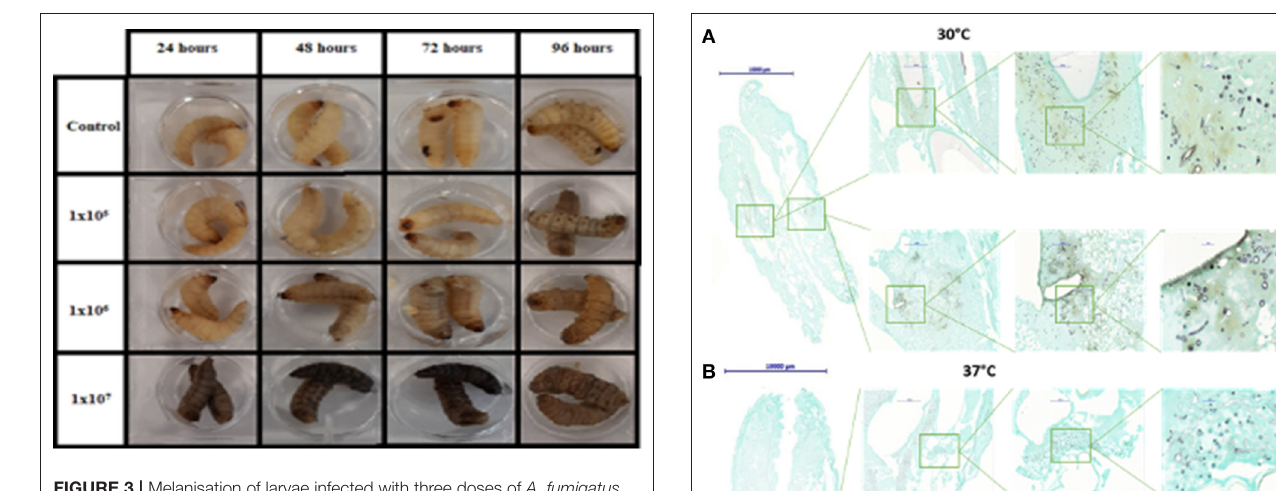
FIGURE 3 | Melanisation of larvae infected with three doses of A. fumigatus conidia over 96h.